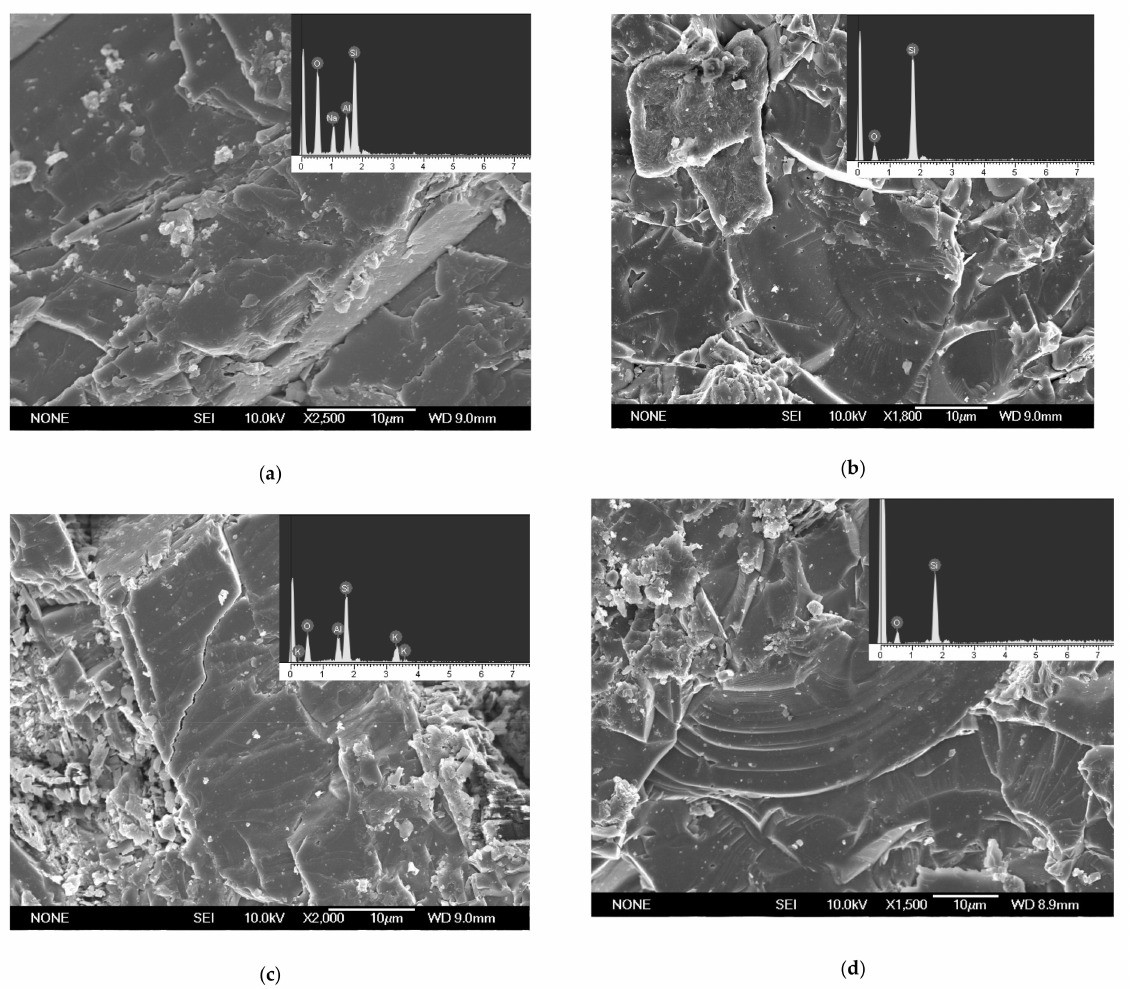
Figure 4. Granite slices surface prior to the experiment. ( a ) Low-albite. ( b ) Quartz. ( c ) K-feldspar. ( d )